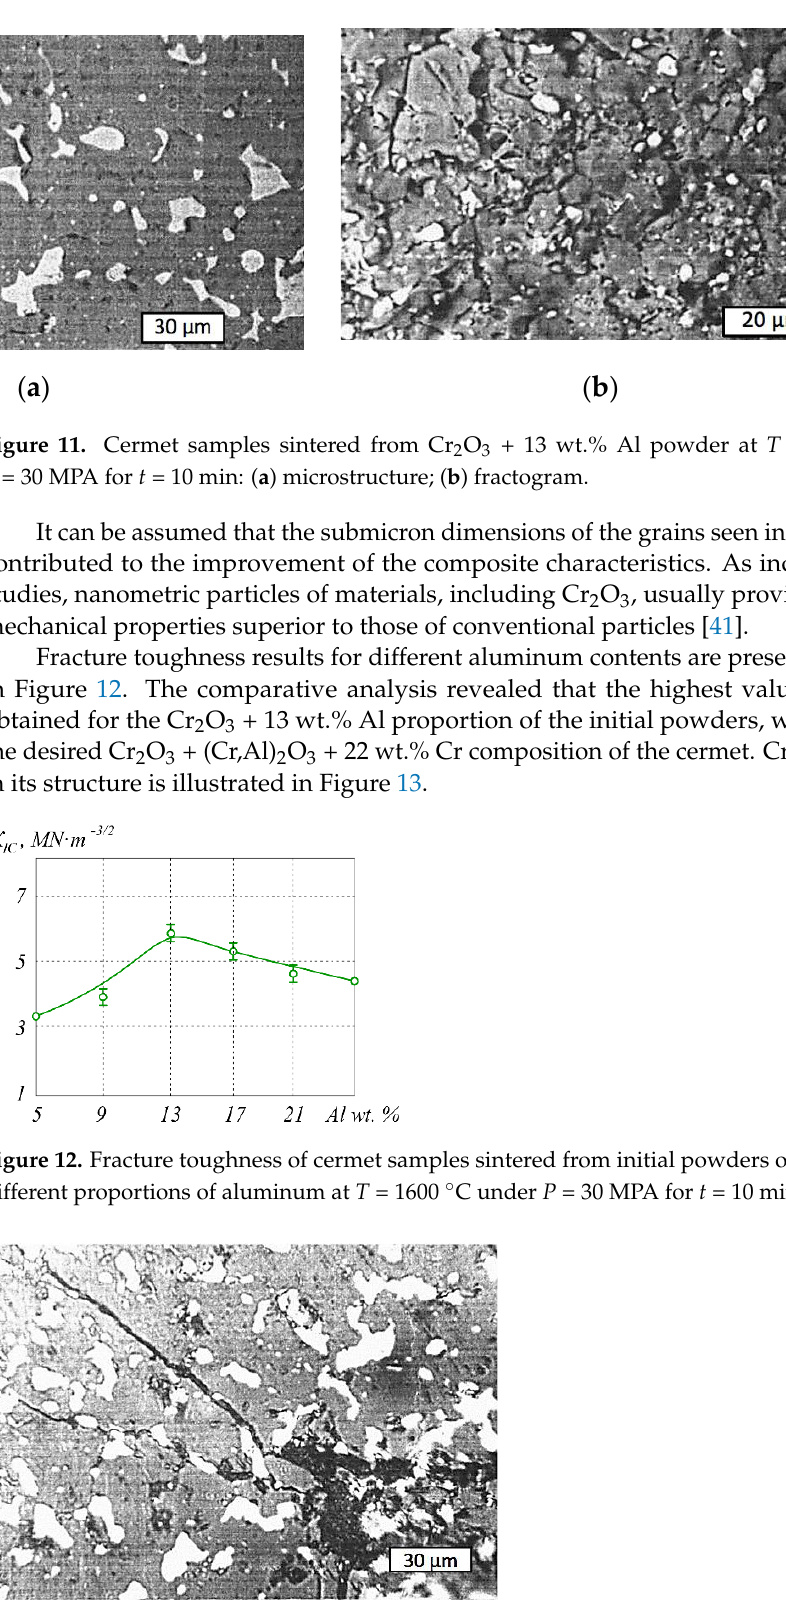
Figure 10. Dependence of flexural strength on sintering temperature of different cermets hot pressed under P = 30 MPa for t = 10 min: 1 —Сr 2 O 3 + (Cr,Al) 2 O 3 + 22 wt.% Cr; 2 —Сr 2 O 3 + (Cr,Al) 2 O 3 +